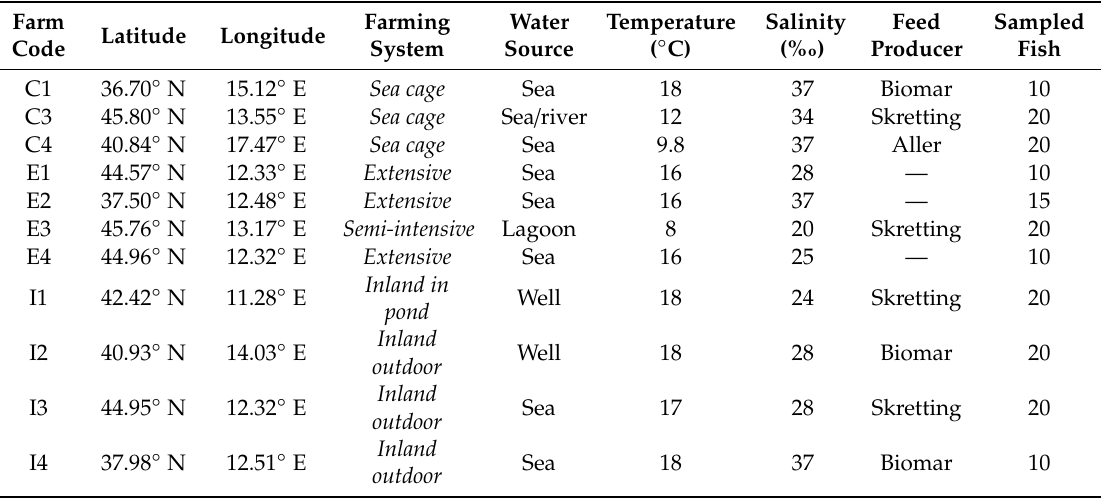
Table 1. General farms characteristics, water quality, commercial feed producer, and number of fish